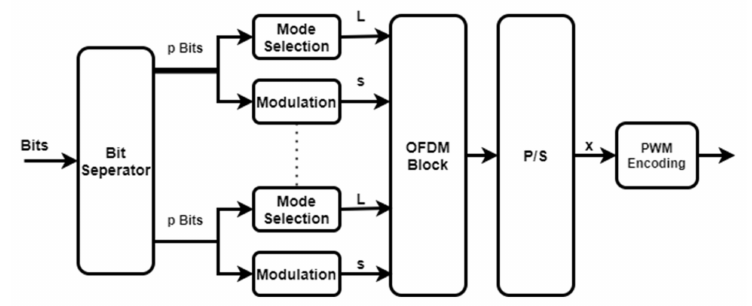
Figure 4. OFDM-IM transmitter system block diagram.